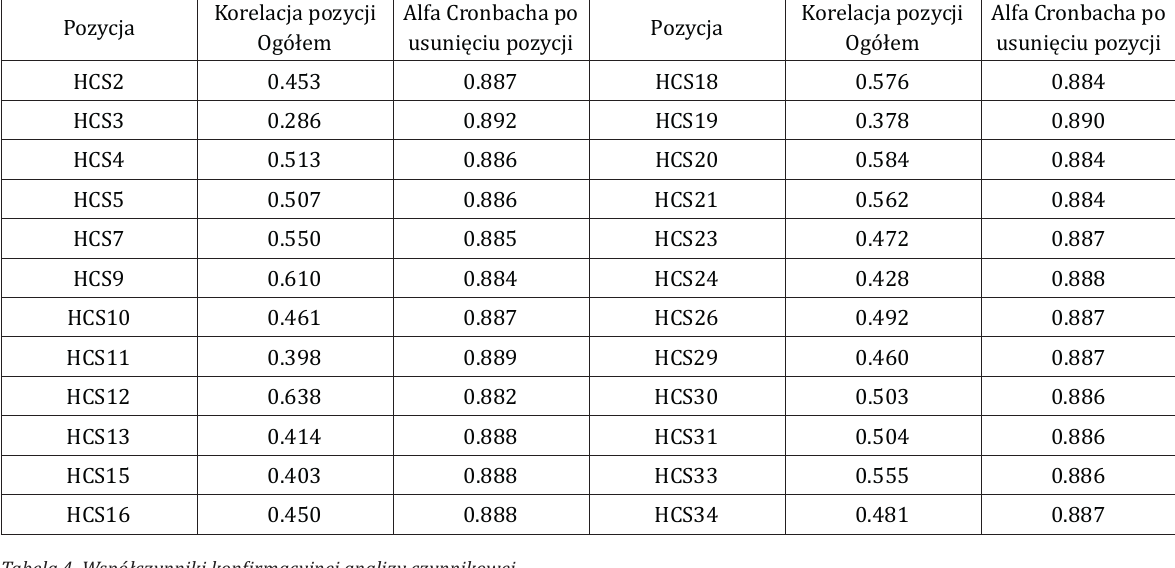
Tabela 3. Rzetelność pozycji HCS